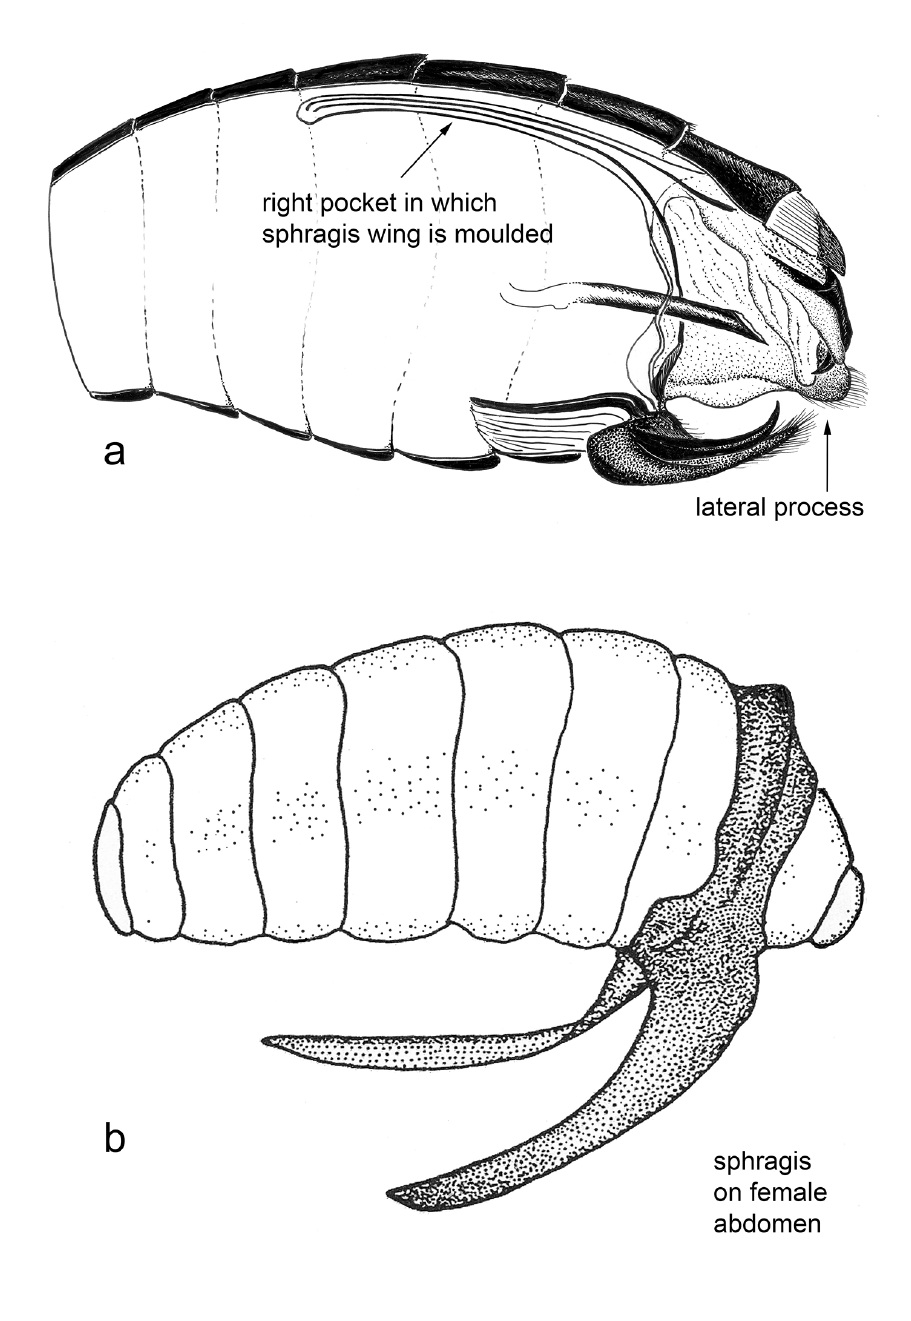
Figure 34. Example of male adaptations associated with sphragis production: a parasagittal section of Euryades corethrus male showing deep pockets where sphragis wings are molded and other features associ- ated with sphragis production b The finished sphragis in situ on the female